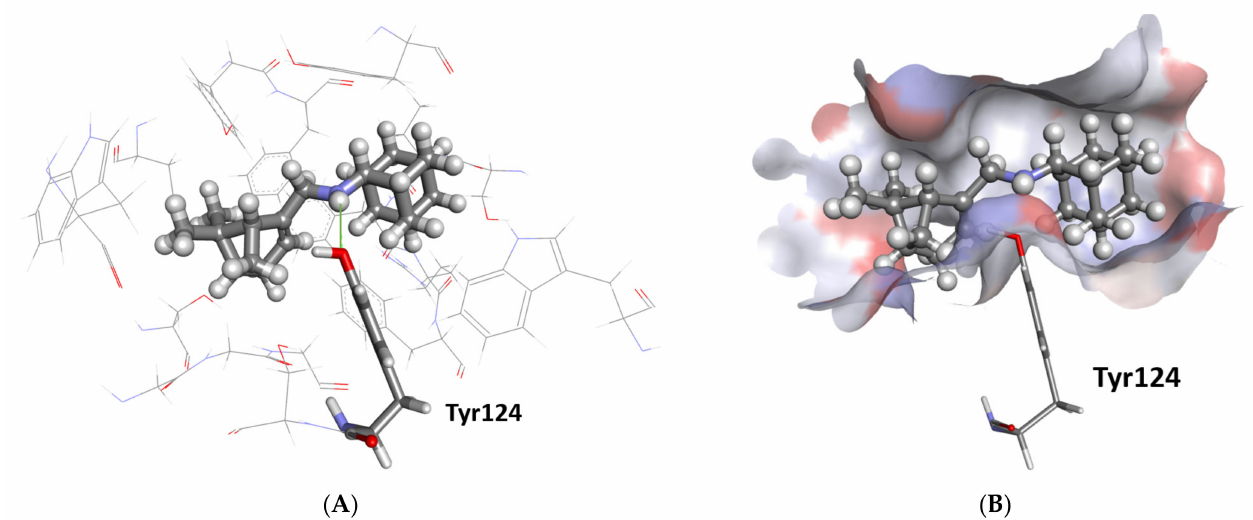
Figure 5. The docked pose of MAC-197 in the binding site of AChE as predicted by the ChemPLP scoring function. ( A ) The predicted configuration is shown in the ball-and-stick format, and the hydrogen bonding to Tyr124 (stick format) is shown as a green line. The amino acids forming the lipophilic binding pocket are Trp86, Gly120, Gly121, Gly122, Trp286, Val294, Phe295, Phe297, Tyr337, Phe338, Tyr341, and His447; they are shown as lines. ( B ) The protein surface is rendered; blue depicts regions with a partial positive charge on the surface; red depicts regions with a partial negative charge, and grey shows neutral areas. The ligand occupies the deep binding